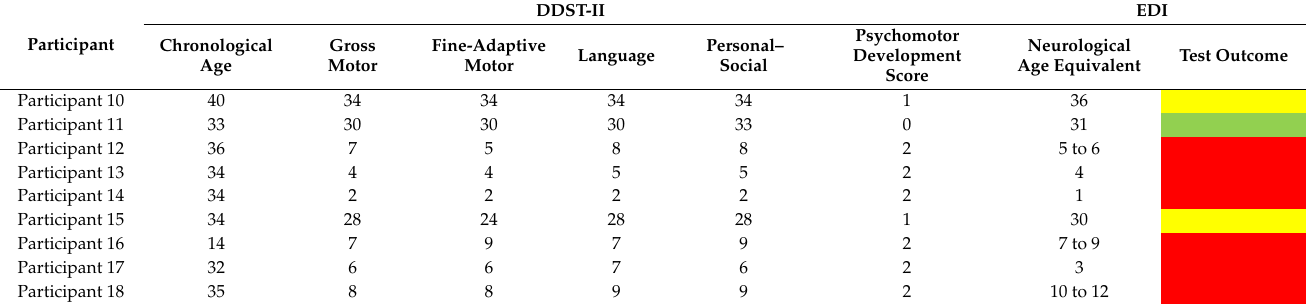
10 to 12 Ages are represented in months. ZIKV: Zika virus. DDST-II: Denver Developmental Screen Test II. EDI: Evaluation of Infant Development. Psychomotor development score (DDST-II): 2: Delay, 1: Risk, 0: Normal, Test outcome (EDI): Risk of developmental delay: the child does not ade- quately achieve the developmental milestones and skills expected for his/her age group and is sig- nificantly delayed because he/she has not achieved the milestones of the previous age group or has high-risk signs such as red flags or has an abnormal neurological